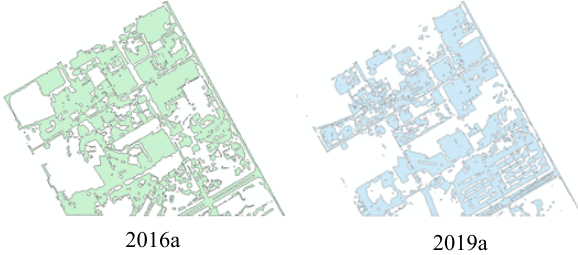
Figure 2. an impermeable layer in the extraction area